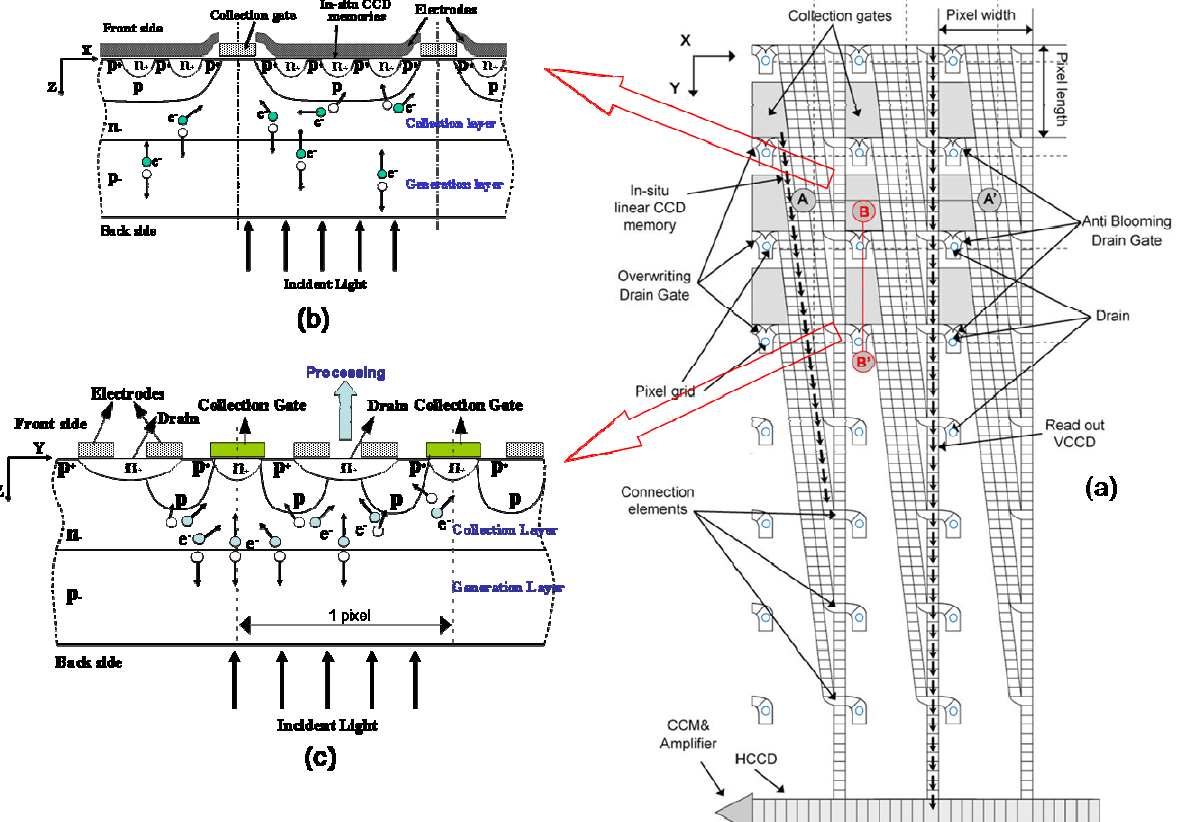
Figure 2. The ISIS-100M structure (a) Front-side ISIS structure (b) Cross-section structure along A-A' (c) Cross section structure along